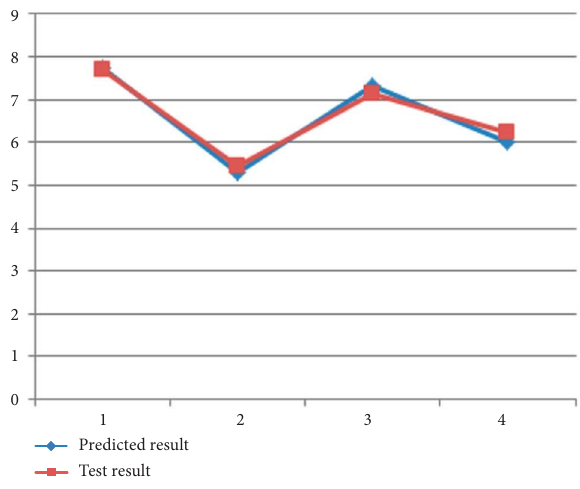
Figure 24: Warpage deformation fit comparison. Table 10: Error between the prediction and test